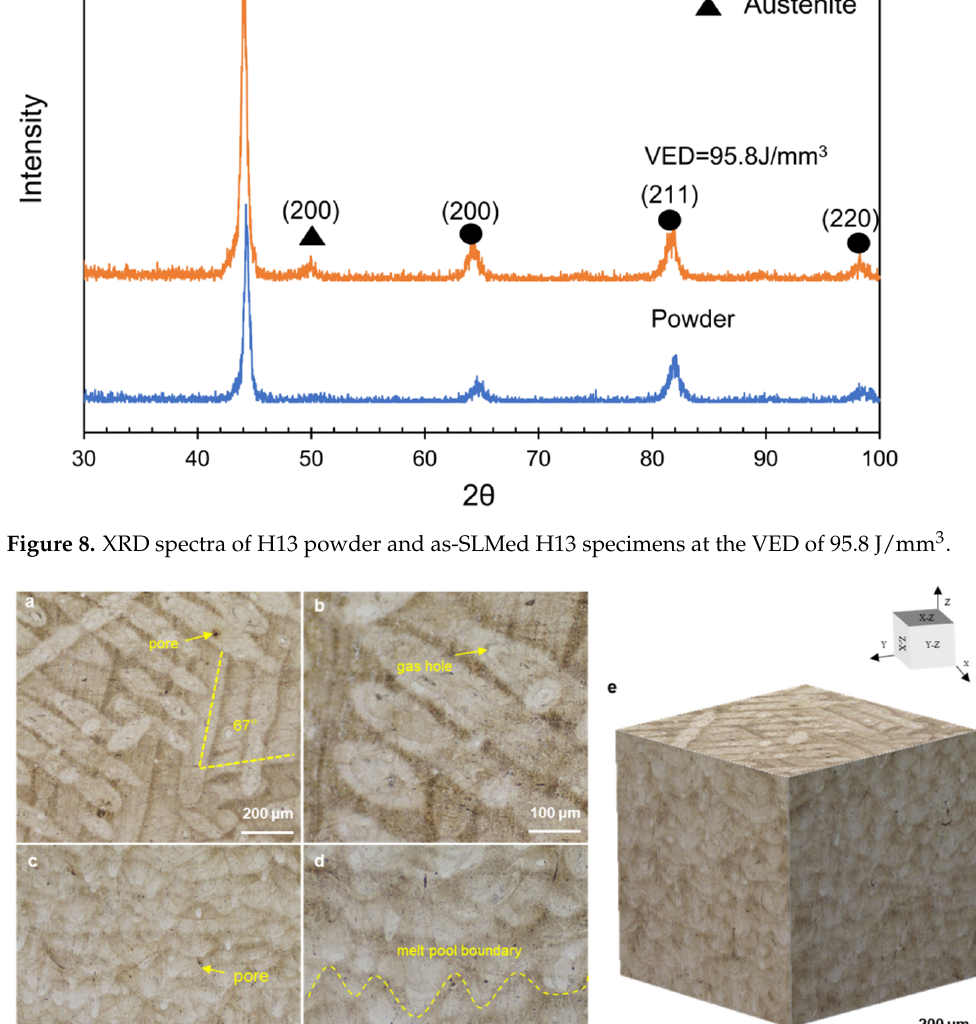
Figure 9. Optical micrographs showing the microstructure along ( a , b ) horizontal direction and ( c , d ) building direction; and ( e ) isometric view.